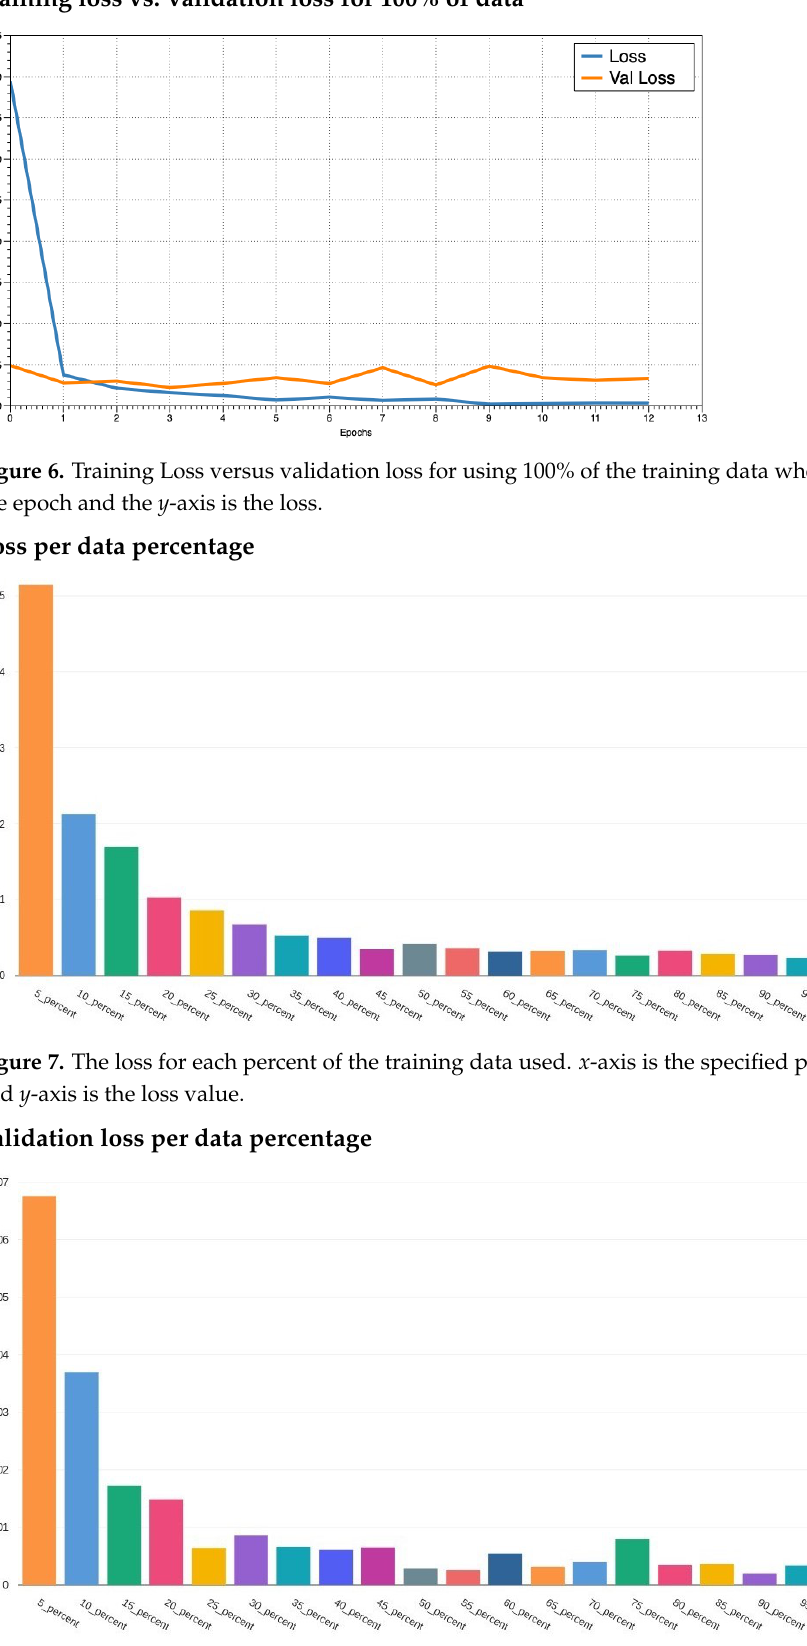
Figure 8. The validation loss for each percent of the training data used. x -axis is the specified percentage used and y -axis is the loss